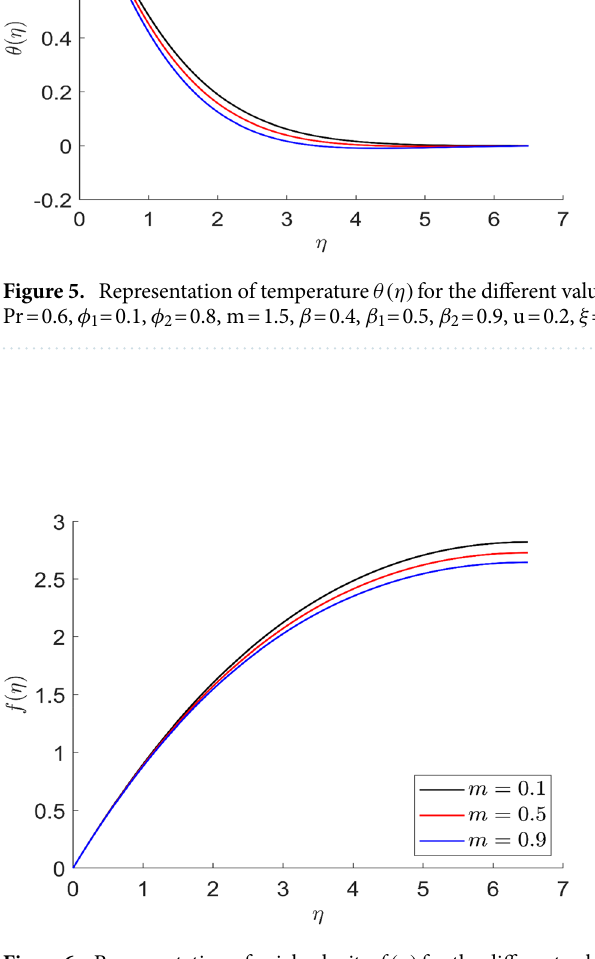
Figure6. Representation of axial velocity f (η) for the different values of m with R = 3, n = 3, v = 0.1, φ = 0.2, Pr = 0.6, φ 1 = 0.4, φ 2 = 0.8, β 3 = 0.5, β = 0.4, β 1 = 0.5, β 2 = 0.9, u = 0.2, ξ =